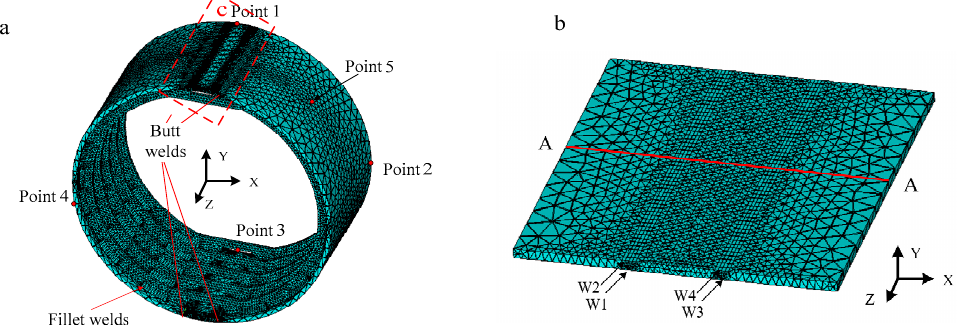
3 of 15 Figure 1. The welding structure and finite element (FE) model. ( a ) Welding structure: first, the stiffeners (C) were welded onto the cylinder substructures (D) by 24 separate fillet welds; the welding fixtures (E) were installed on the whole structure to make sure it would not collapse; then, parts A and B were removed by machining; finally, the five cylinder substructures were welded together by four butt welds. ( b ) Welding fixture, 1 ‐ Vertical supporting claws; 2 ‐ Horizontal supporting claws; 3 ‐ Central spindle; 4 ‐ Linkage and rolling wheel. As no metallurgical phase transformation occurs in the aluminum alloy used in this work, the volumetric effects due to the phase transformation on residual stress evolution are not considered here; the procedure seems acceptable to achieve accurate stress and distortion distribution in references [18]. Since welding processes undergo a high temperature cycle and exhibit material properties that are temperature dependent, the thermal and mechanical properties of the 5A06 aluminum alloy in Table 3 were determined by the Probability Design System (PDS) in the fi nite element software ANSYS [19]. The FE model and the butt welds for inherent strain estimation are shown in Figure 2. In the mechanical analysis, the fillet welds´ thermal stresses and distortion were calculated from the temperature distribution determined by thermal elasto ‐ plastic FE model in references [10,20]. The material was assumed to follow the Von Mises yield criterion and fl ow rule here. The 20 ‐ node hexahedral element SOLID185 was applied in this investigation. These thermal strains of SOLID185 element change linearly for stress analysis. Moreover, the element thermal strain can be confirmed if each node ʹ s mutative temperature and anisotropic thermal expansion coefficient matrix are defined, i.e., inherent strain components could be mapped to the elasto ‐ plastic model in forms of t equivalent thermal strain. Table 1. Welding condition parameters. Welding Parameters balance Table 3. Material properties of 5A06 aluminum alloy. Materials properties